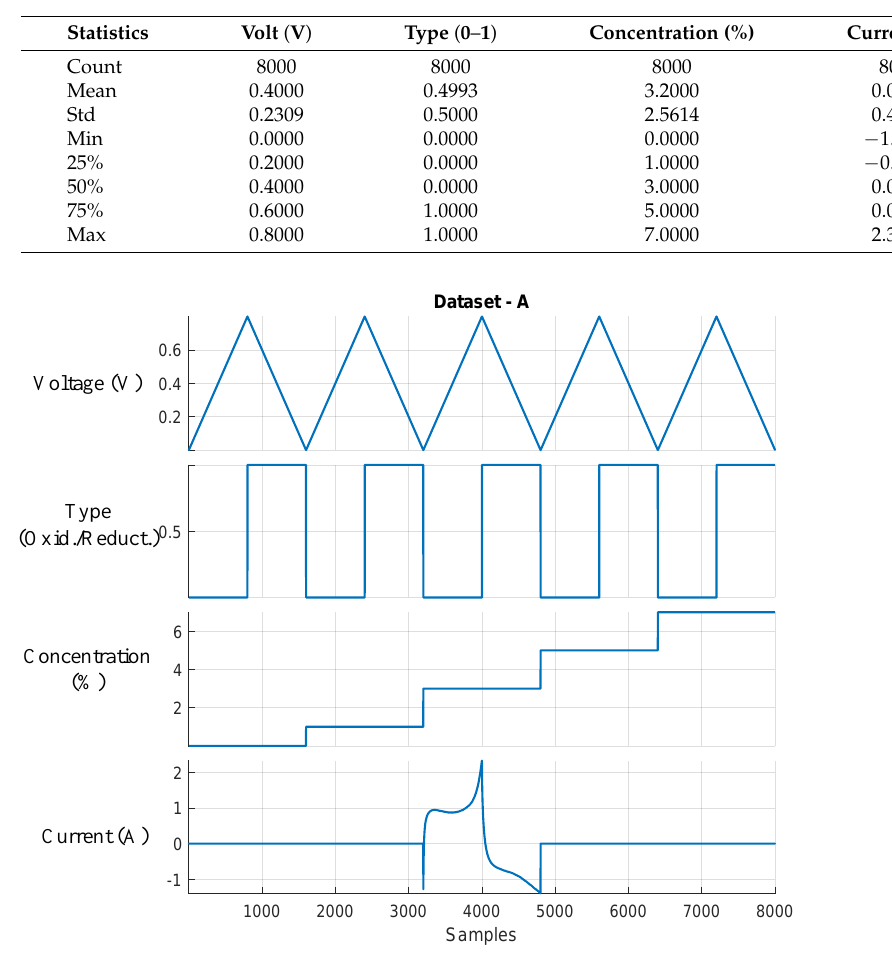
Table 1. Important statistical values of Dataset A.